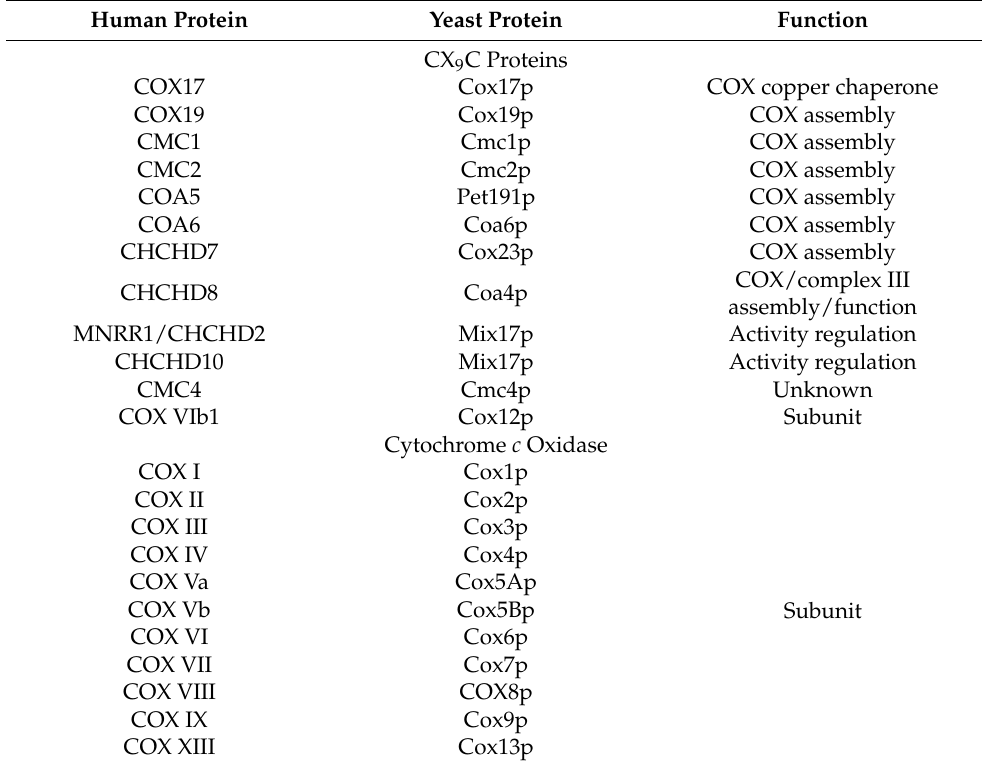
Table 2. Human and yeast proteins, nomenclature, and functions of twin CX 9 C proteins with COX